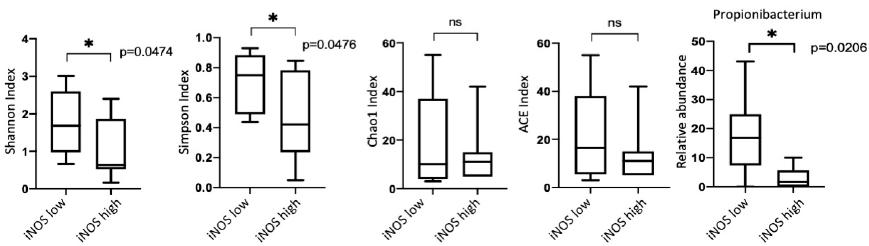
Figure9. Taxonomicdiversitybetweengroupswithdi ff erentiNOSexpression( ∗ Figure 9. Taxonomic diversity between groups with different iNOS expression (* - statistically significant).